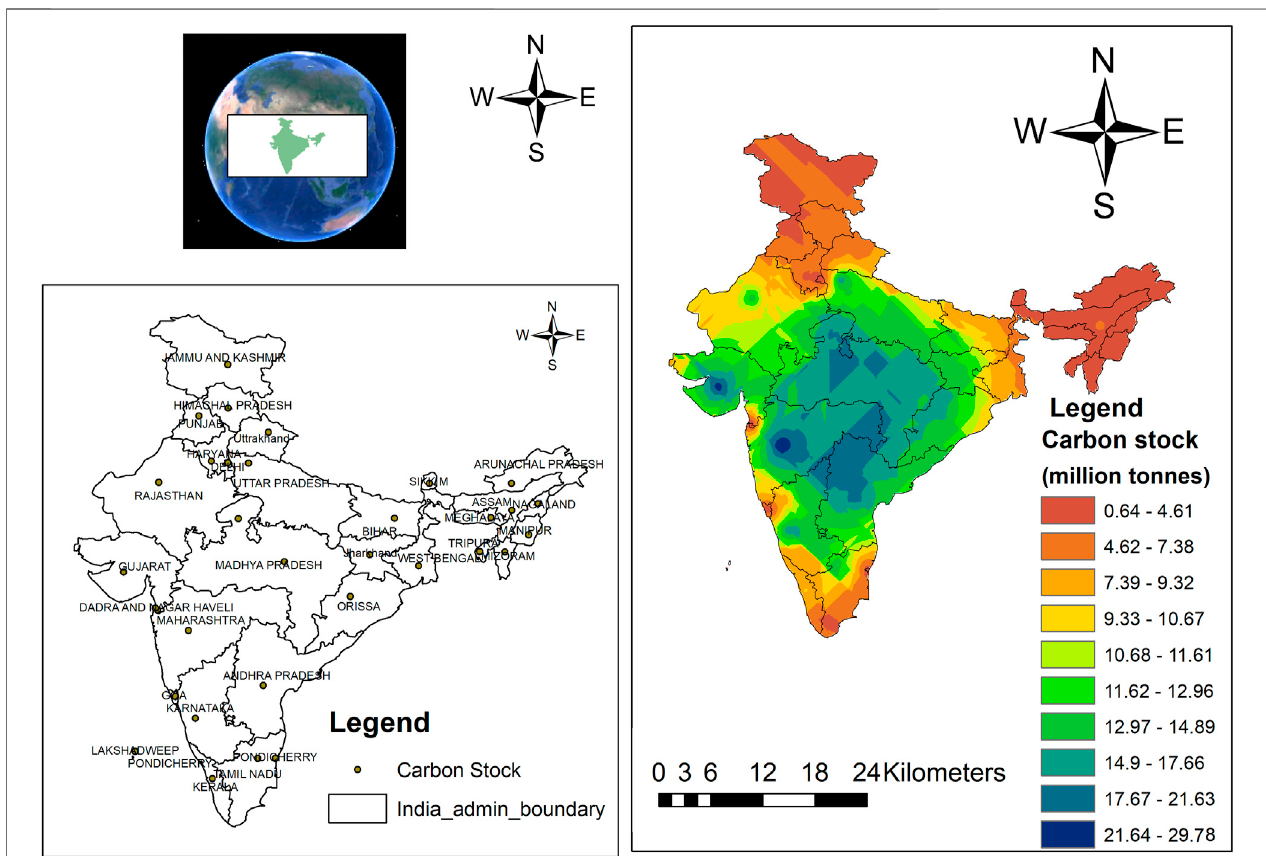
FIGURE 1 | Region-wise carbon stocks under Indian agroforestry systems (Source: FSI, 2013).